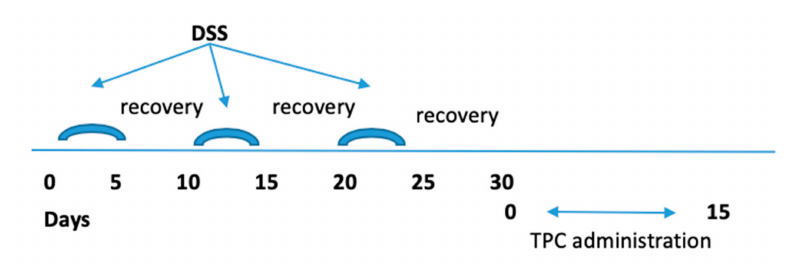
Figure 1. Chronic experimental colitis model and Tuftsin–Phosphorylcholine (TPC)